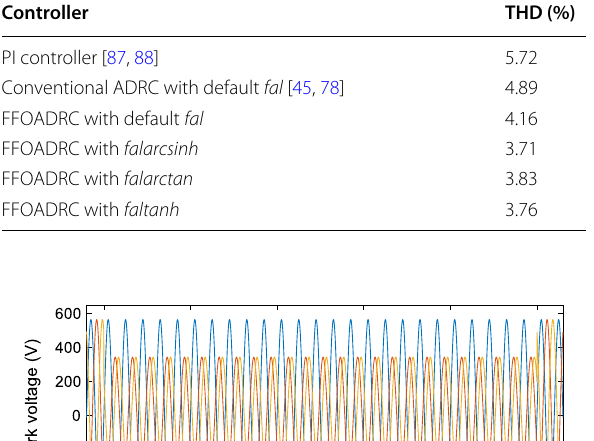
0.01 ohm, ( b ) R crowbar =